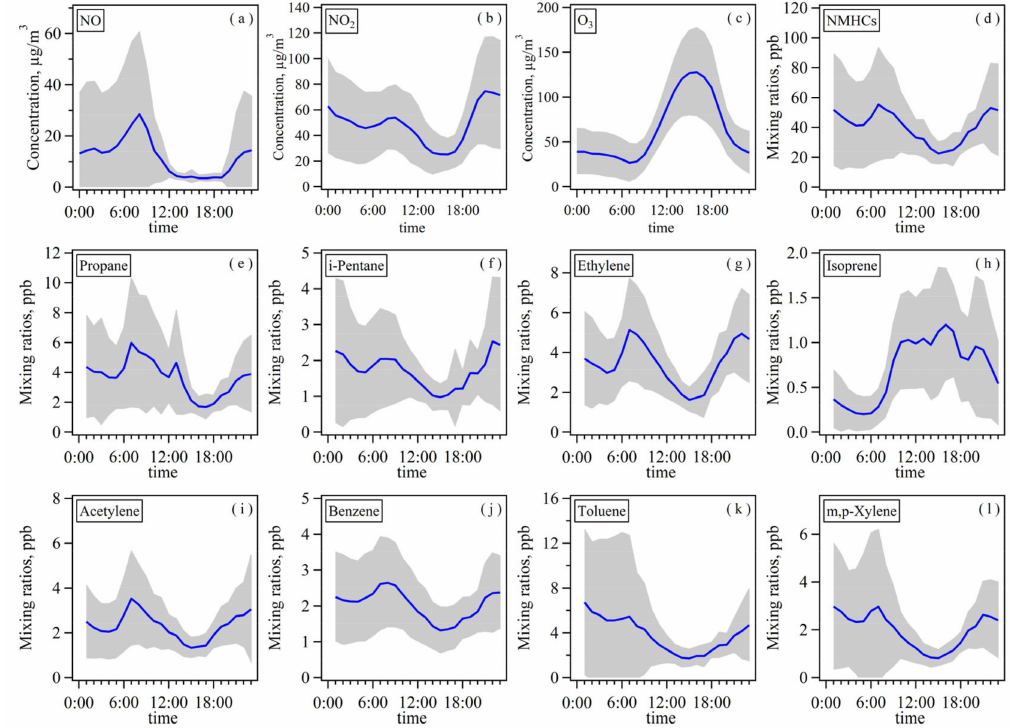
Figure 3. Average diurnal variation pattern for concentrations of ( a ) NO, ( b ) NO 2 , and ( c ) O 3 , and mixing ratios of ( d ) NMHCs, ( e ) propane, ( f ) i -pentane, ( g ) ethylene, ( h ) isoprene, ( i ) acetylene, ( j ) benzene, ( k ) toluene, and ( l ) m,p -xylene. Blue lines represent average values and grey shaded areas indicate standard